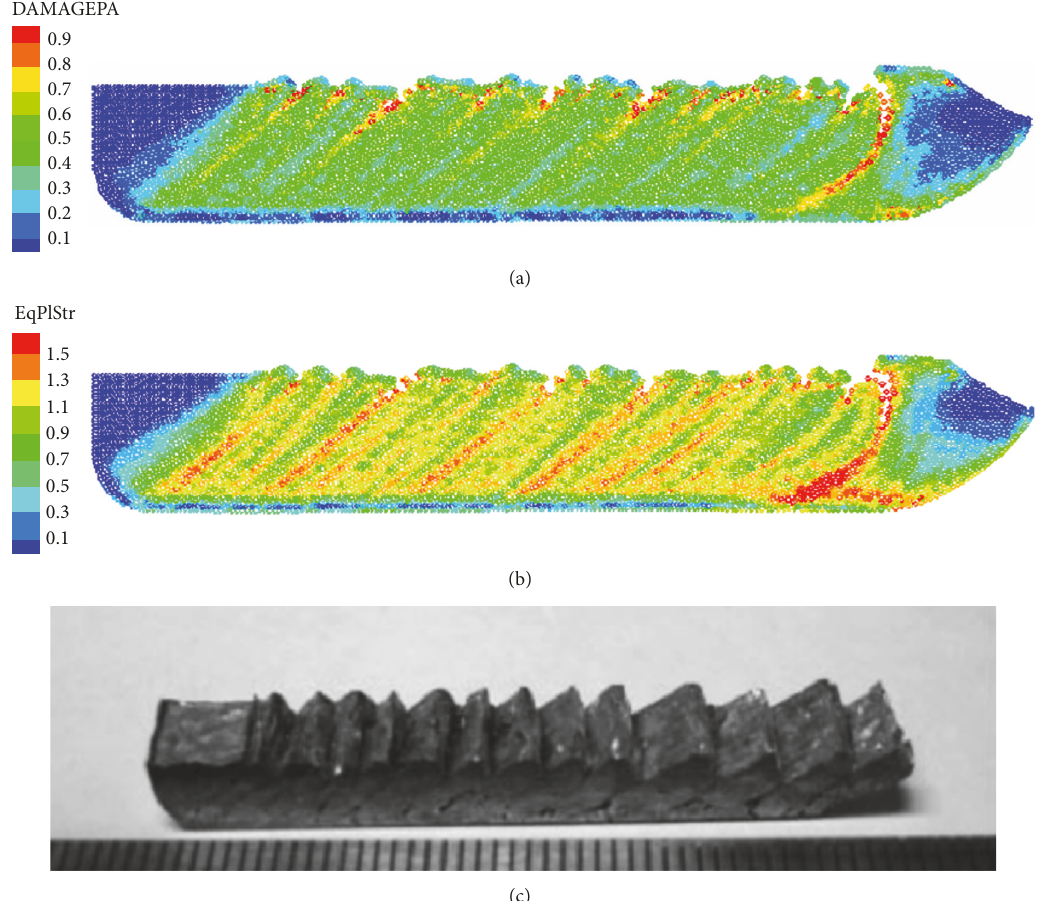
Figure 8: Simulation results of room temperature ECAP of pure magnesium. (a) Computation results of accumulated damage value based on SPH. (b) Computation Results of equivalent strain based on SPH. (c) Test